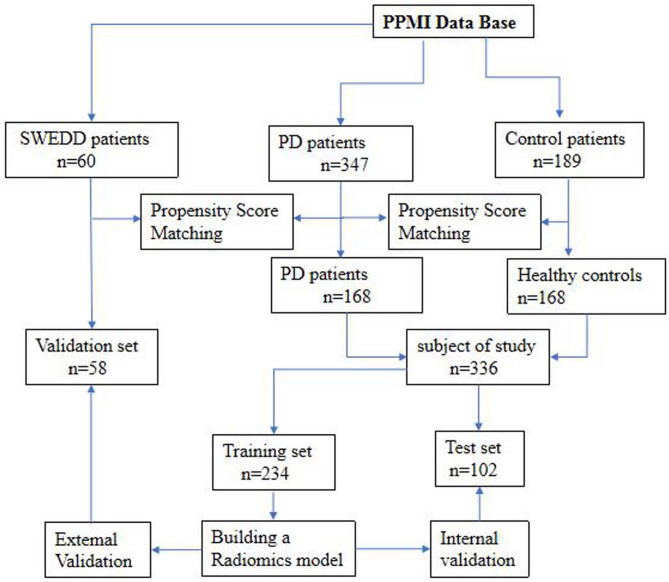
Flowchart of the recruitment process in the current study.